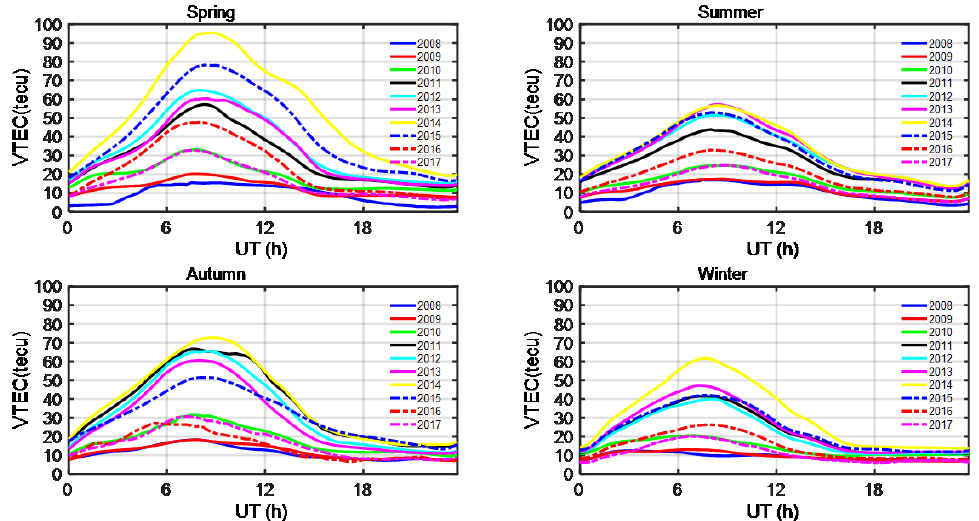
Figure 7. Mean yearly seasonal variations in VTEC for 2008 to 2017 at KKN4.